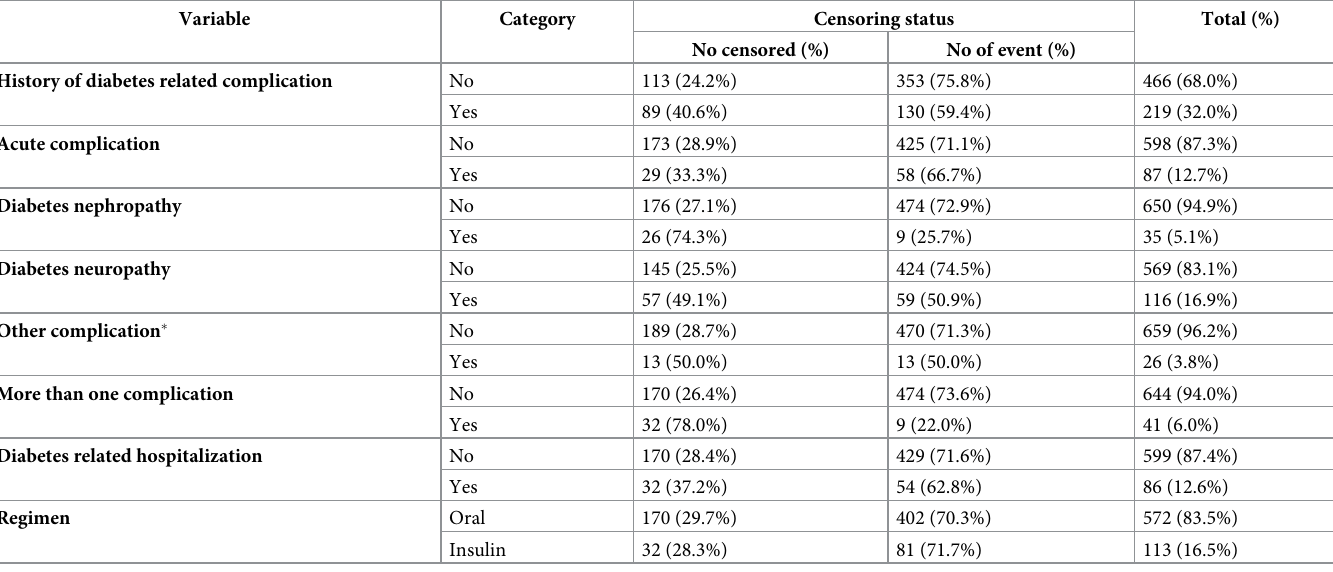
Table 2. Diabetes related variables and censoring status among T2DM patients, Addis Ababa, 2018 (n =